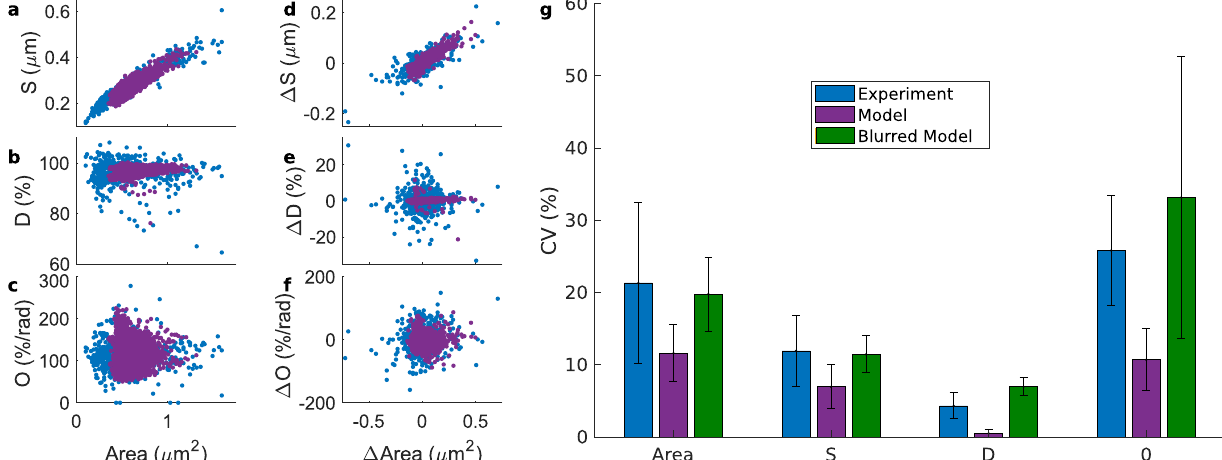
Figure 6. Comparison between experimental data and model. ( a–c ) Spine area against shape descriptors S , D and O . Each dot represents a data point at a sampled time frame. There are 16 spines sampled every 10 s for 5 min corresponding to experimental data from Fig. 3 (in blue) and frames for the model (purple) correspond to 10 simulations in which shapes are sampled every 10 s from minute 10 to minute 60. ( d–f ) Changes in shape descriptors from the data in ( a – c ) against changes in area. ( g ) Median ± standard deviation of the coefficient of variability for shape descriptors calculated for each spine, in experimental data or in the model. Green bar corresponds to the CV’s of the model sampled shapes, but